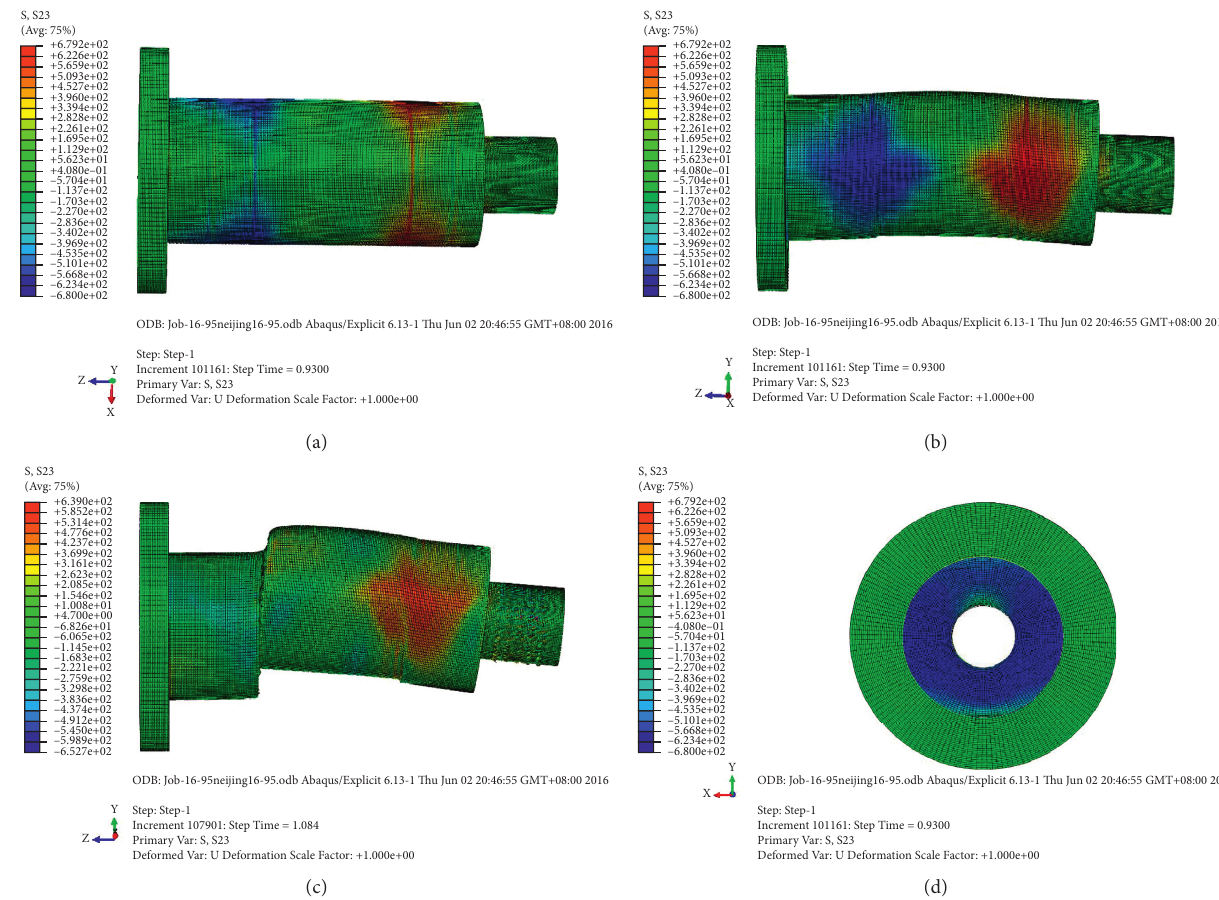
Figure 16: Fuse pin stress contour at the latest time. (a) Initial moment of load loading. (b) Moment of loading to 70% ultimate load. (c) Separation point. (d) Pin section at the separation point.